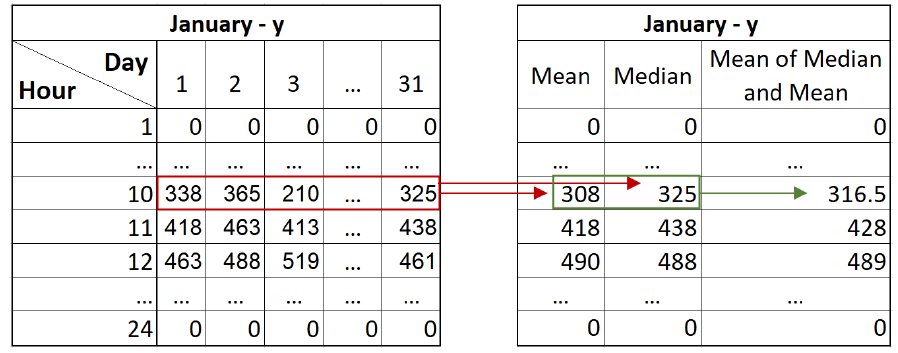
Figure 7. Example of working principle: grouping the average into one value per hour per month.